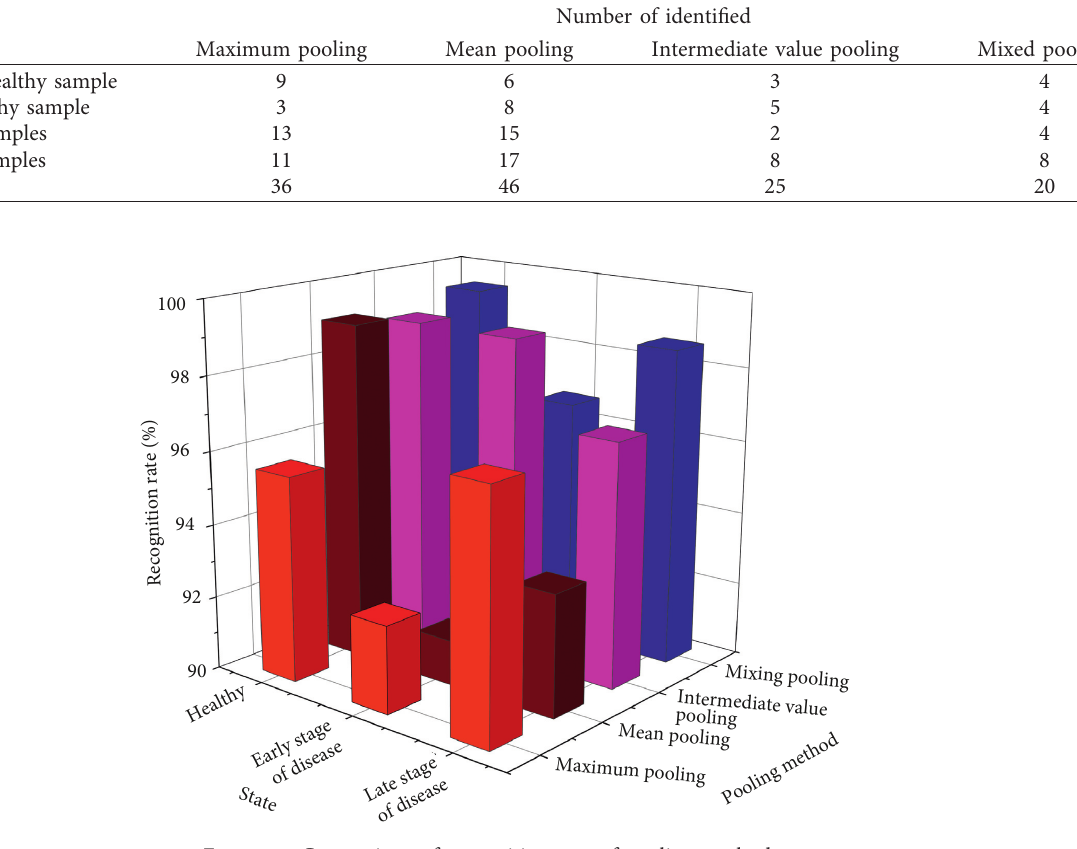
Figure 7: Comparison of recognition rate of pooling